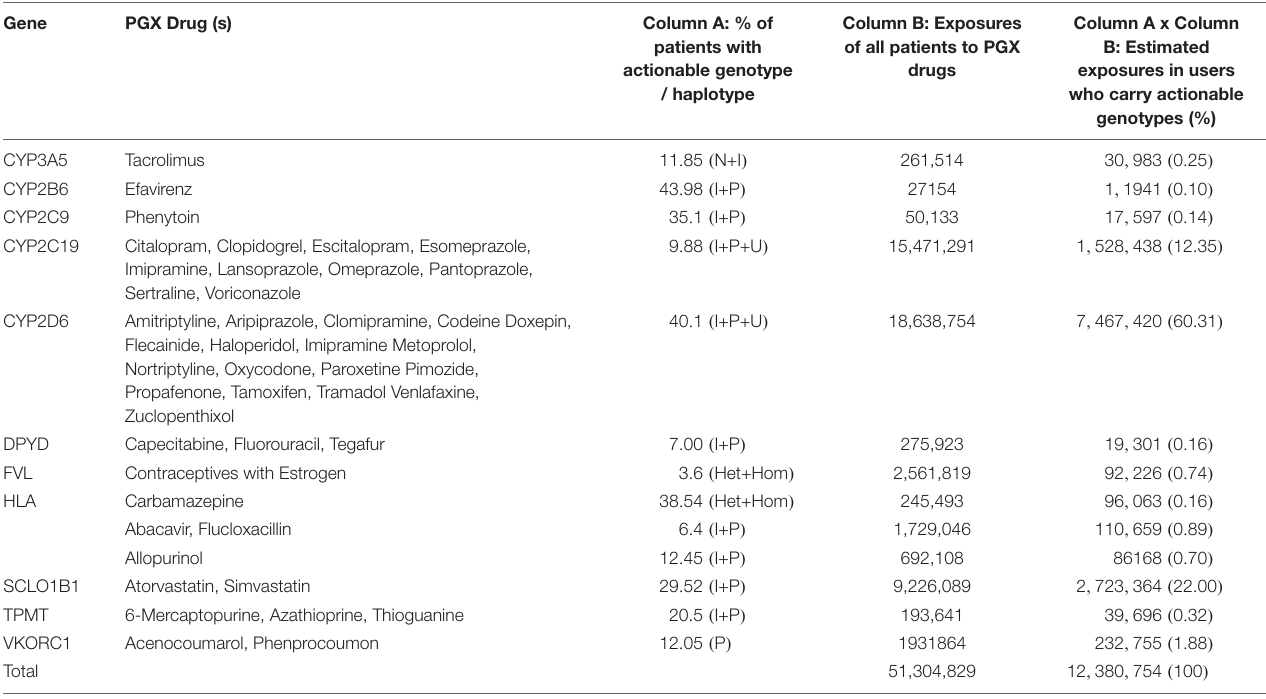
TABLE 4 | Number of patients’ exposed to PGX drugs from 2011 to 2017 and the genes involved. Gene PGX Drug (s) Column A: % of